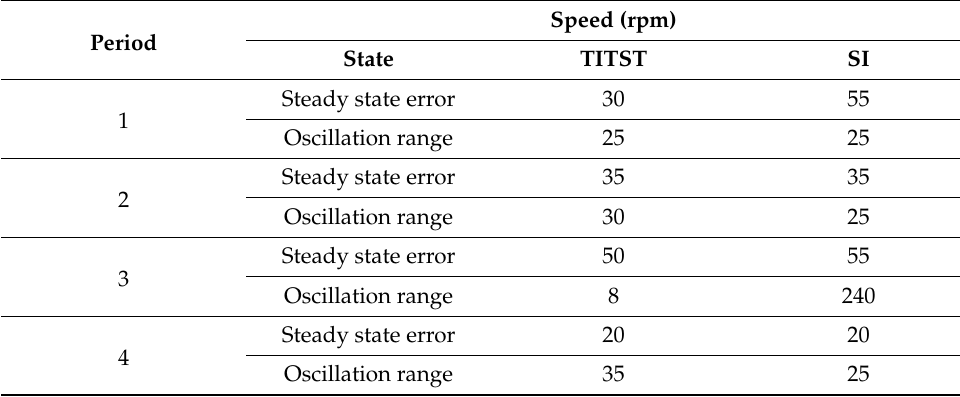
Table 4. Assessment of speed to TITST against SI controllers. Period